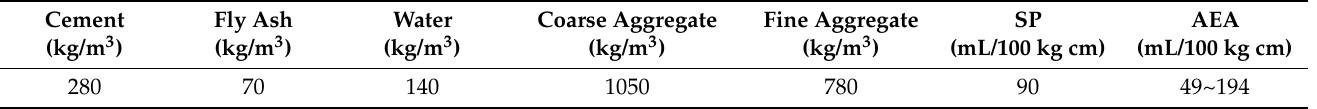
Table 4. Mix proportions of fly ash concrete